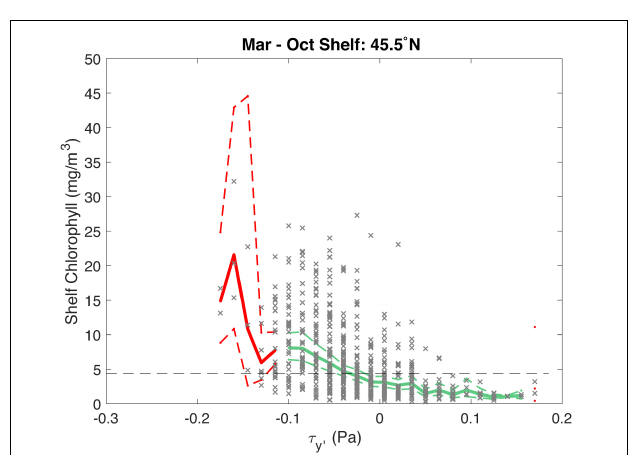
FIGURE 5 | Example of chlorophyll vs. wind stress bins for the shelf at 45.5 ◦ N. The mean shelf chlorophyll concentration for each bin is plotted in the solid green line. The dashed green lines represent the 95% confidence intervals for each bin that is used in further analysis. The 8-day chlorophyll concentration data corresponding to each wind stress bin for this latitude band are plotted in gray. The dashed black line is the global mean shelf chlorophyll concentration (4.34 mg/m 3 ). If the difference between the high confidence interval and low confidence interval for each bin was greater than the global mean (4.34 mg/m 3 ), then that bin was ignored in further analysis; these bins are represented by the solid and dashed red lines, representing the mean and 95% confidence intervals for those